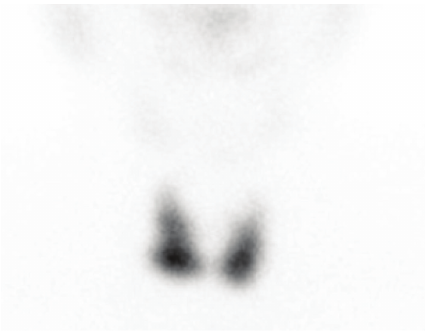
Figure 2: Technetium scan revealing bilateral diffuse increased tracer uptake at 5.9% [normal 0.5–3.5%], consistent with Graves’